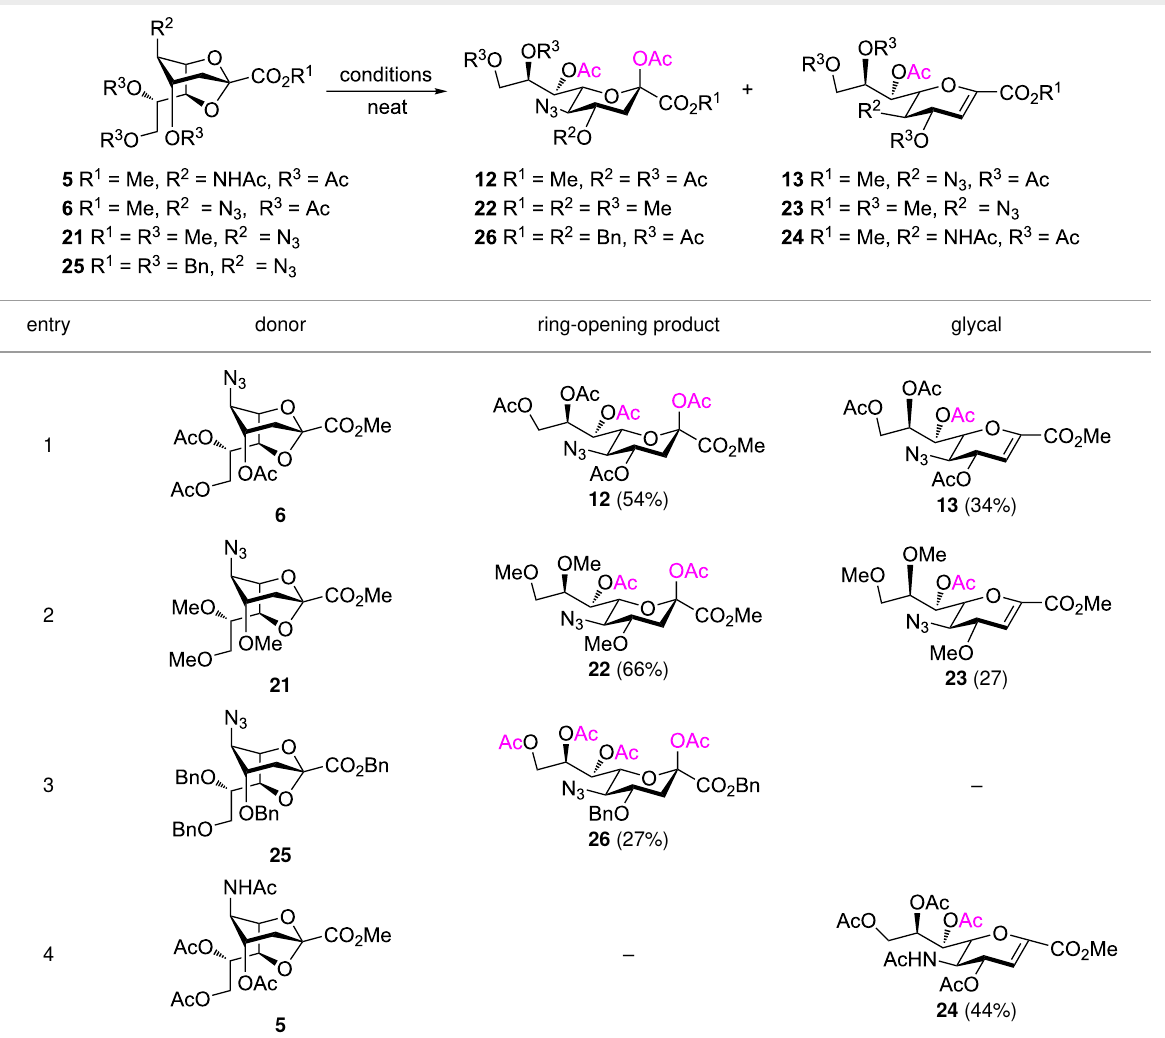
Table 2: Substantiation of the reaction